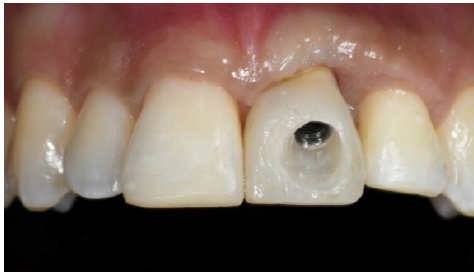
Figure 12. Five months after implant placement, management of soft tissue with screw-retained temporary restoration.